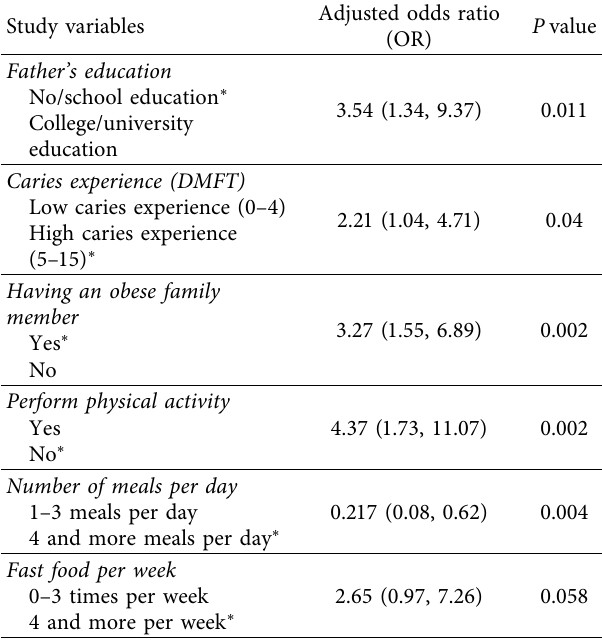
Table 4: Multiple logistic regression final model (backward stepwise (likelihood ratio)): association of caries experience and other factors with obesity in study